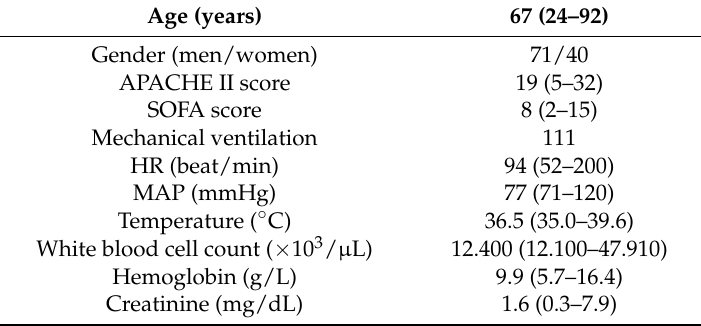
Table 1. Baseline demographic, clinical, and laboratory parameters of the study population ( n = 111)